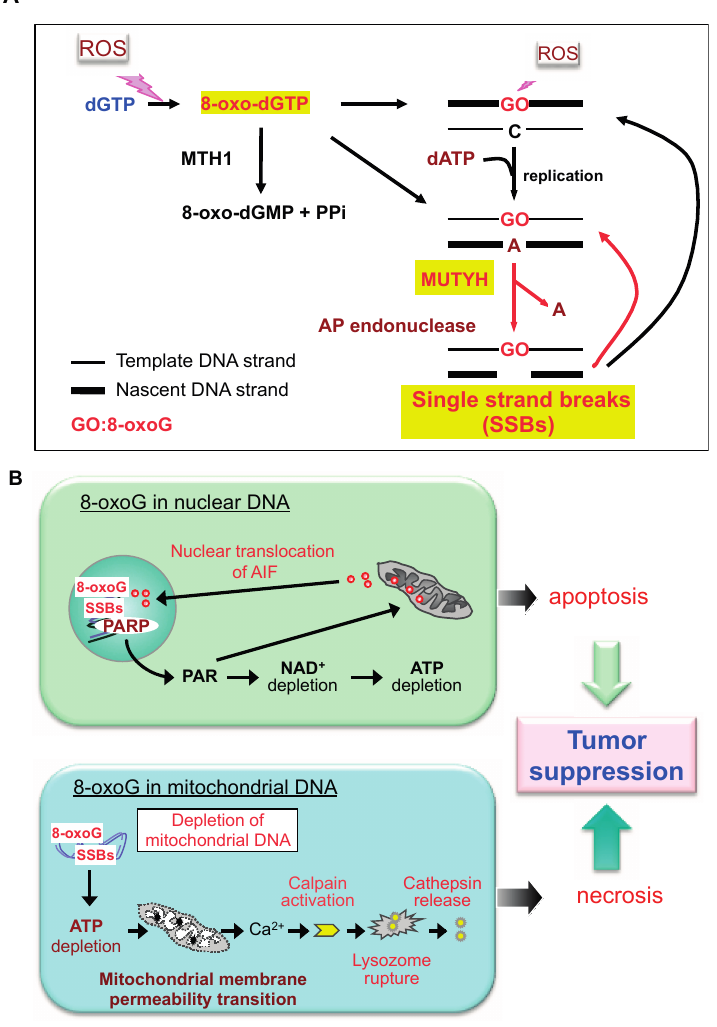
Figure 3. MUTYH-dependent programmed cell death triggered by accumulation of 8-oxoG in nuclear and mitochondrial DNA. ( A ) 8-oxo-dGTP generated in the nucleotide pool is a main source of 8-oxoG accumulated in DNA, which causes accumulation of SSBs in the nascent DNA strand through futile BER initiated by MUTYH. ROS, reactive oxygen species; Red arrows, futile BER cycle; ( B ) Two distinct cell death pathways induced by MUTYH-dependent BER. Top panel : When 8-oxoG accumulates to high levels in nuclear DNA, poly(ADP-ribose) polymerase (PARP) binds the SSBs generated by MUTYH-initiated BER. The SSBs activate PARP, thus increasing poly(ADP-ribose) polymer (PAR). Persistent PARP activation results in depletion of both nicotinamide adenine dinucleotide (NAD + ) and ATP followed by nuclear translocation of apoptosis inducing factor (AIF). AIF then executes apoptotic cell death; Bottom panel : Accumulation of high levels of 8-oxoG in mitochondrial DNA causes depletion of mitochondrial DNA through MUTYH-initiated BER, thus causing mitochondrial dysfunction and resulting in activation of calpains, which in turn cause lysosomal rupture leading to cell death. Modified from